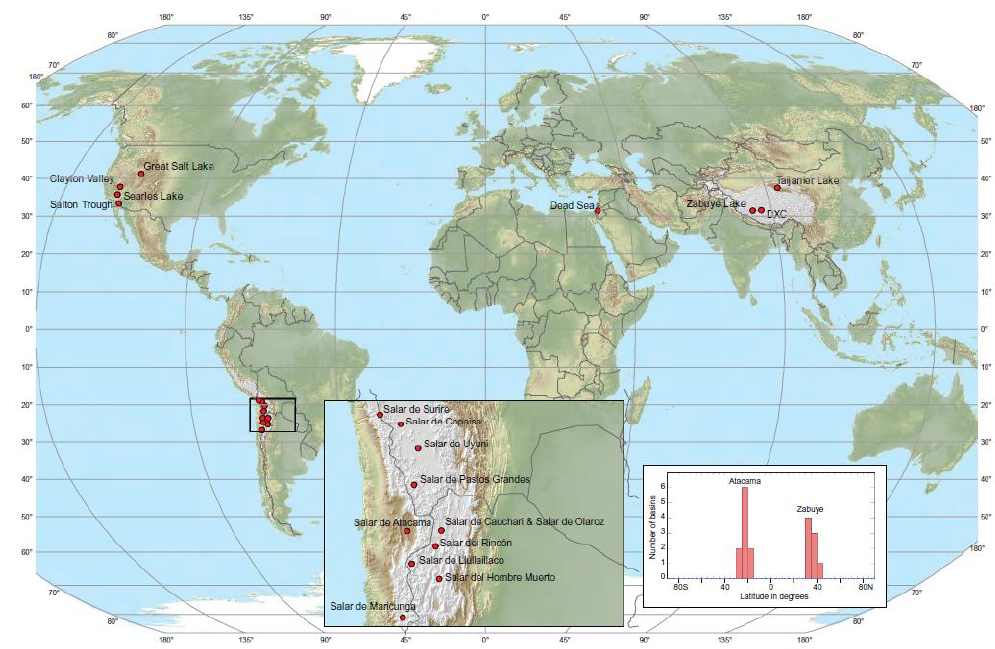
Figure 4. World map of lithium brine deposits [9]. Currently, lithium is produced from brines mostly in South America and Asia. Reproduced with permission of the Society of Economic Geologists, Inc. Munk et al. (2016) Chapter 14: Lithium brines: A global perspective, Reviews in Economic Geology, v. 18, 339–365. Table 1. Lithium and magnesium concentrations in prominent salar and salt lake brines [17]. Separation of lithium and magnesium are important for recovery of battery-grade lithium. Table reproduced from [17]; some calculated ratios have been corrected.